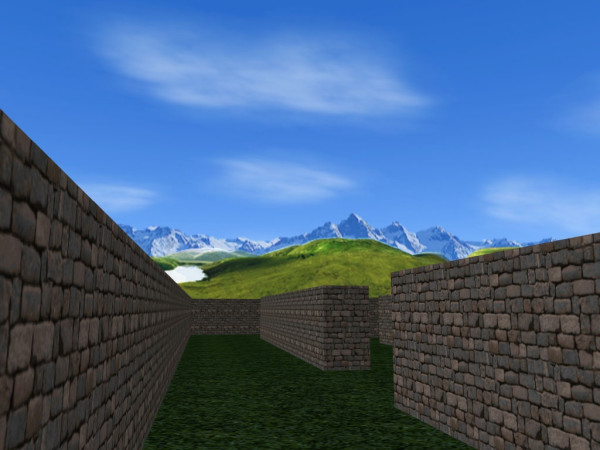
The VR Maze test.